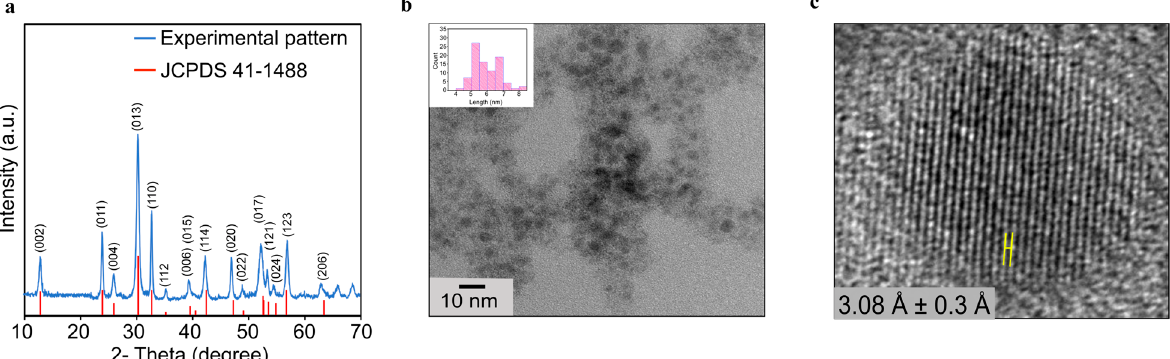
Figure 1. Characterization of (BiO) 2 CO 3 samples. ( a ) Powder XRD patterns of a bulk sample in comparison with the simulated patterns; ( b ) a representative TEM image of BiO) 2 CO 3 NPs with